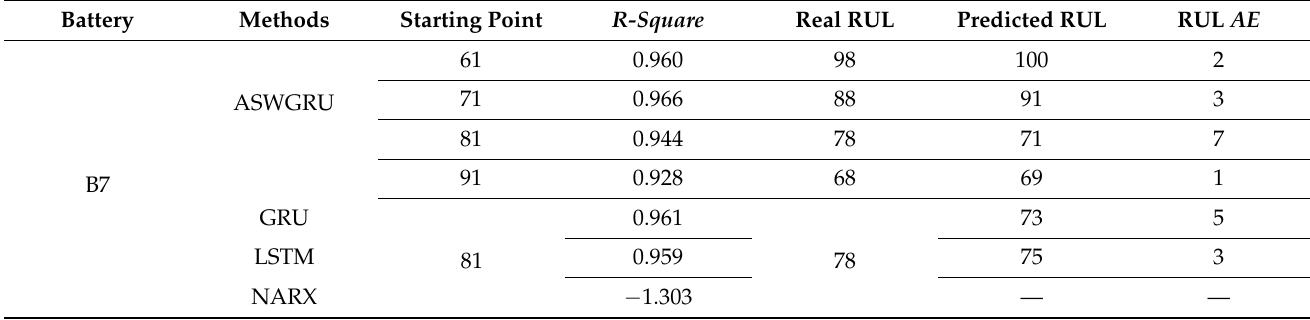
Table 5. The obtained results with different prediction start points for B7.